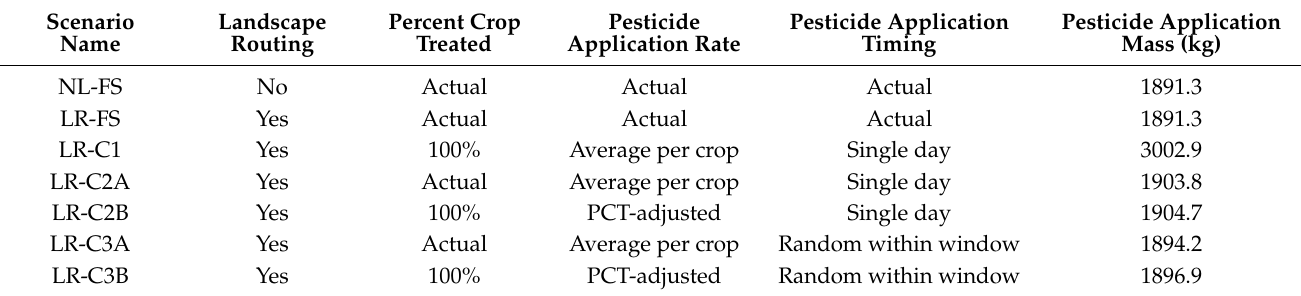
Table 4. List of scenarios evaluated in the study.